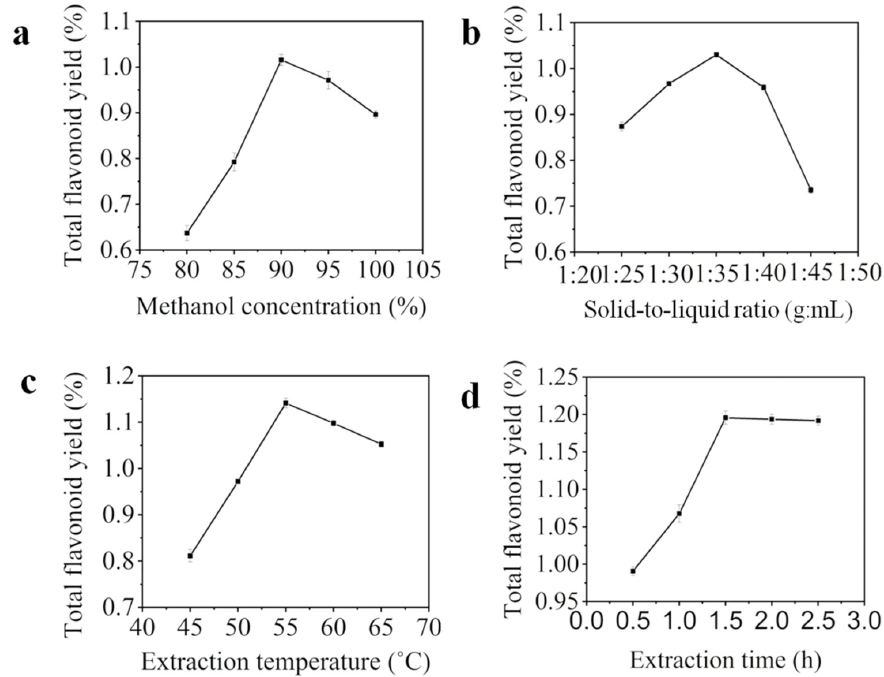
Figure 1. The influence of methanol concentration ( a ), solid-to-liquid ratio ( b ), extraction temperature ( c ) and extraction time ( d ) to total flavonoids yields, respectively.